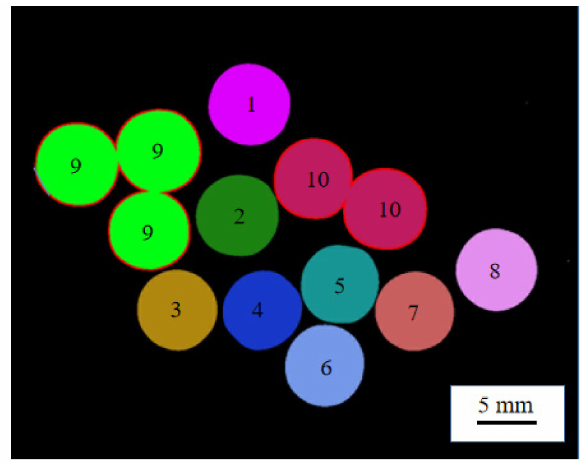
Figure 4. Connected domain labeling. Table 1. Connected domain area and area